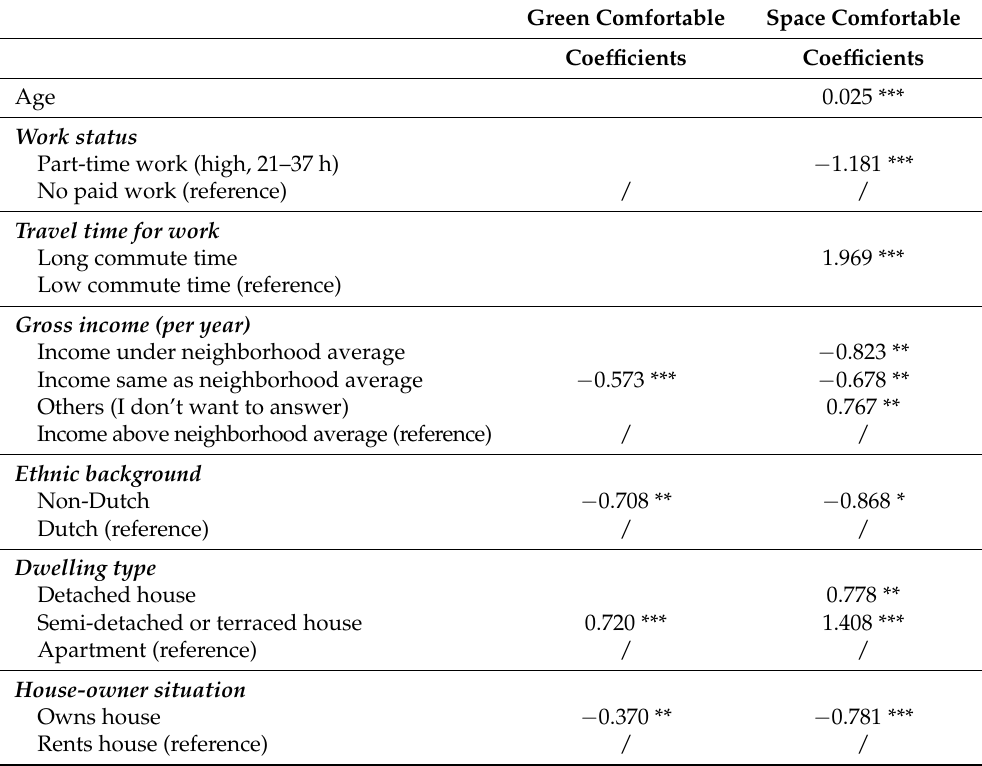
Table 8. Results of the MNL models ( comfortable sense ).